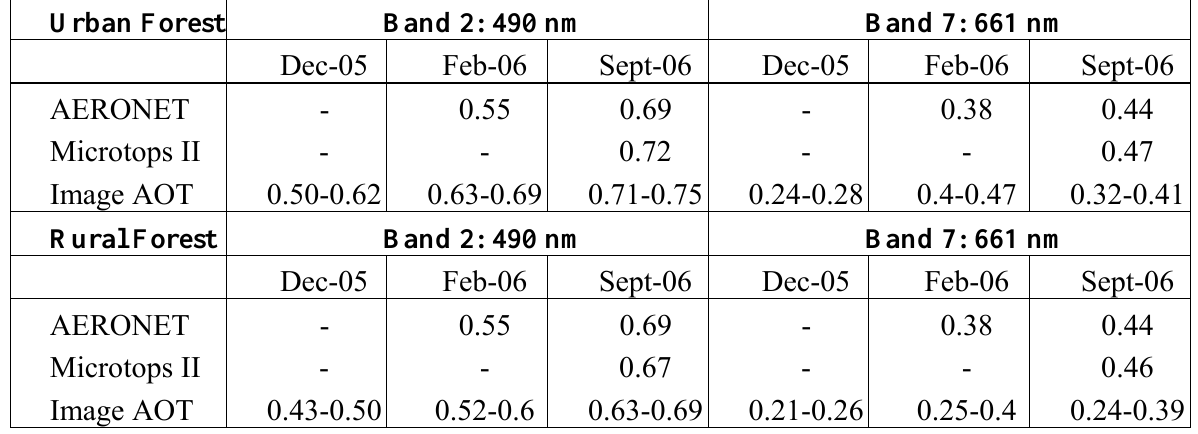
) and Path (aerosol) surf